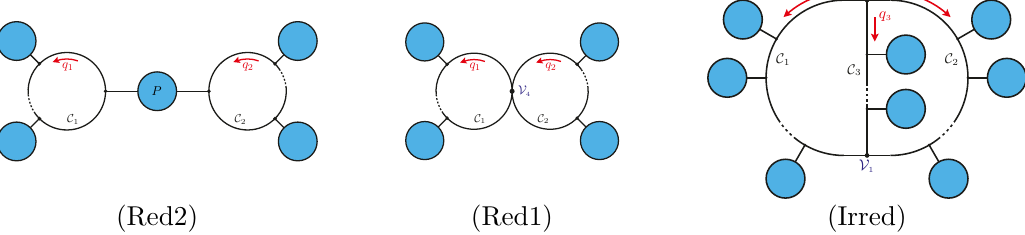
Figure 1 . Categorisation of two-loop topologies into reducible (Red) and irreducible (Irred) ones. Reducible two-loop topologies are further split into two subcategories, where two one-loop subdiagrams are either connected to a bridge through two vertices (Red2) or are attached to each other through a common quartic vertex (Red1). Similarly as in section 3 the blue blobs denote tree structures that are connected to internal and external lines (the latter are not shown). In the Red2 topology the blue blob labelled P can be connected only to the two visible internal lines or also to additional external